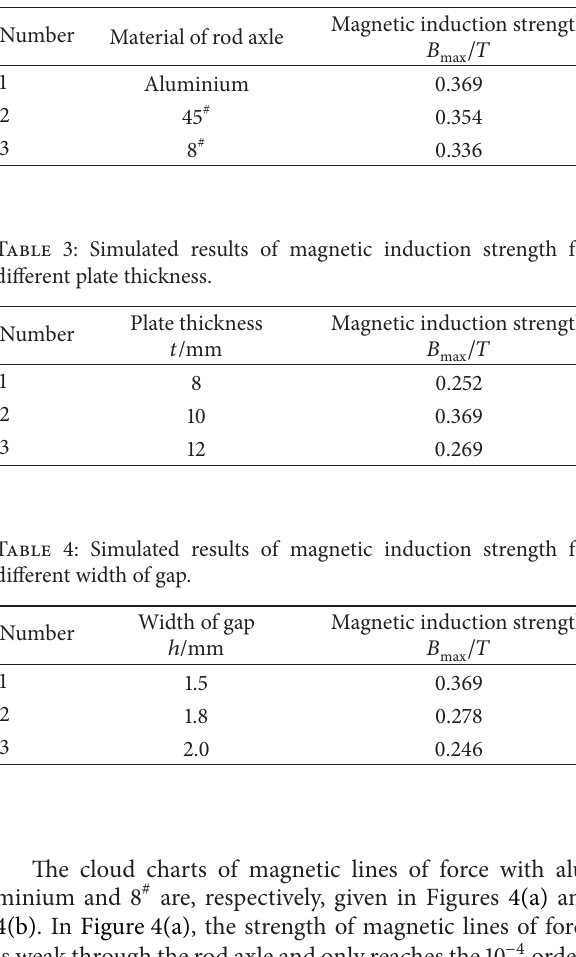
Table 2: Simulated results of magnetic induction strength for different material of rod axle.